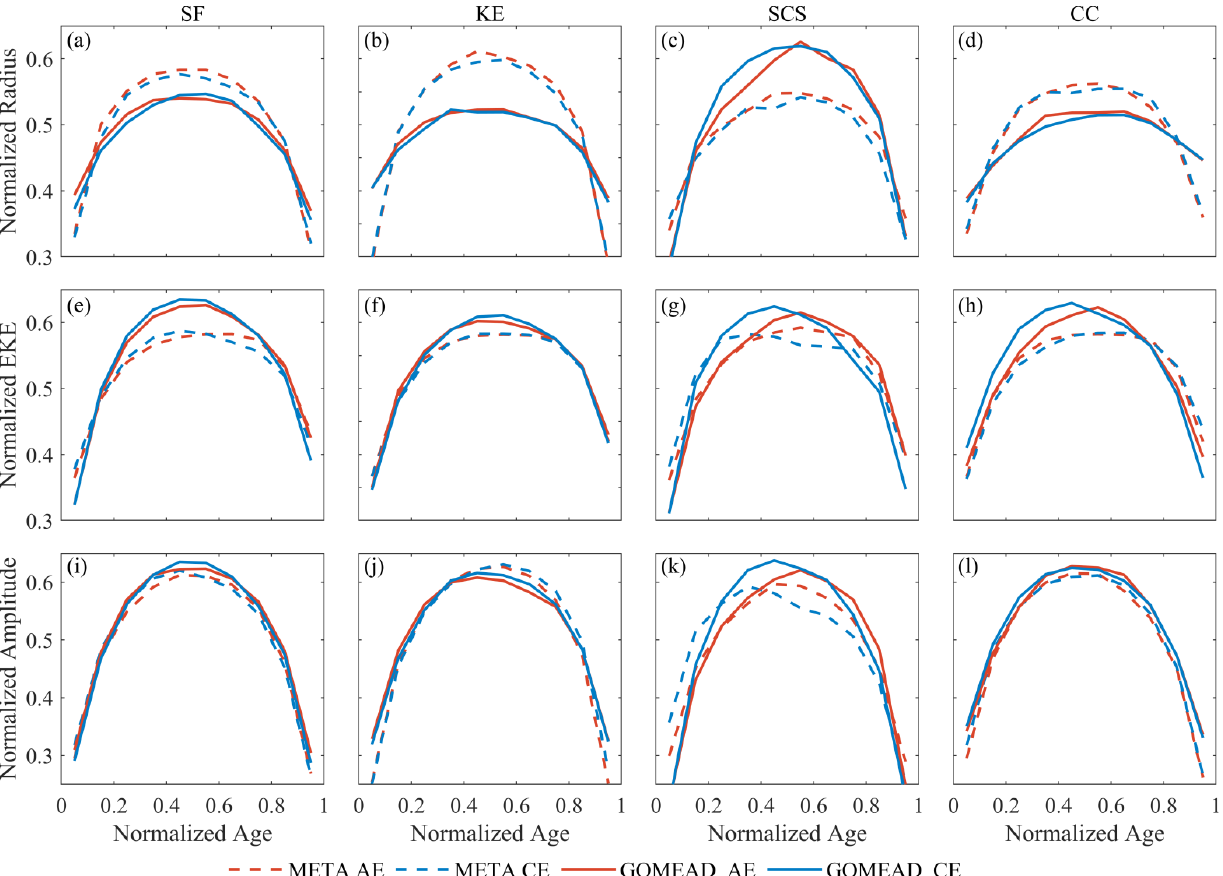
Figure 13. Time evolution of the mean normalized ( a – d ) radius, ( e – h ) EKE and ( i – l ) amplitude. The four columns from left to right represent the normalized parameters of SF, KE, SCS, and CC regions, respectively.